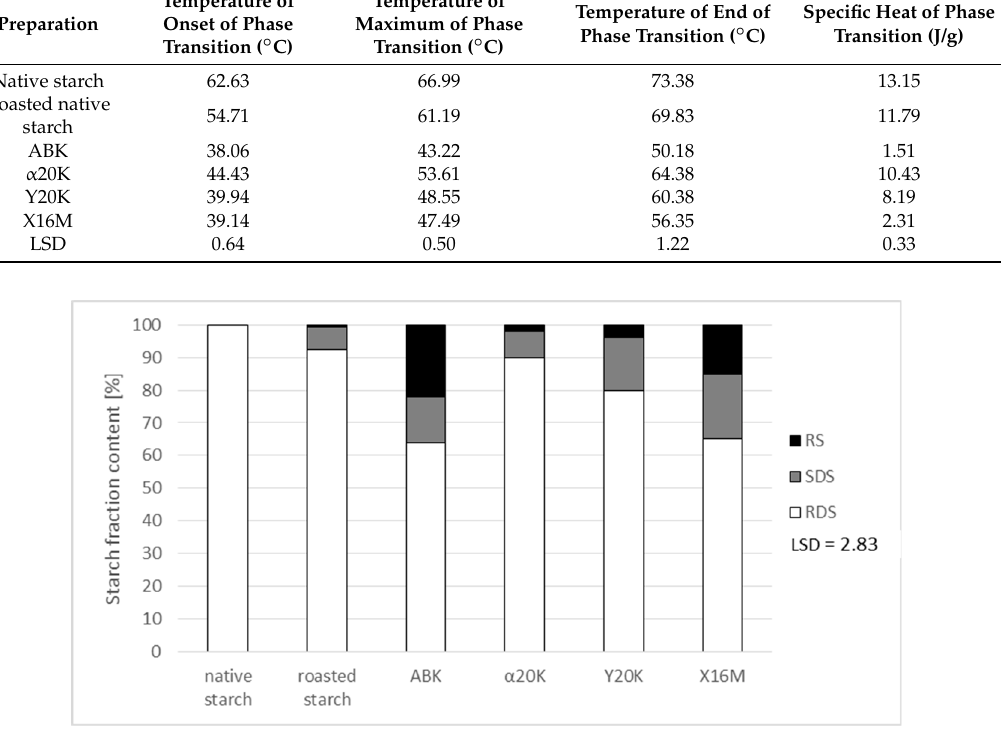
Figure 5. Contents of rapidly-digestible starch (RDS), slowly-digestible starch (SDS) and resistant starch (RS) fractions in starch preparations.